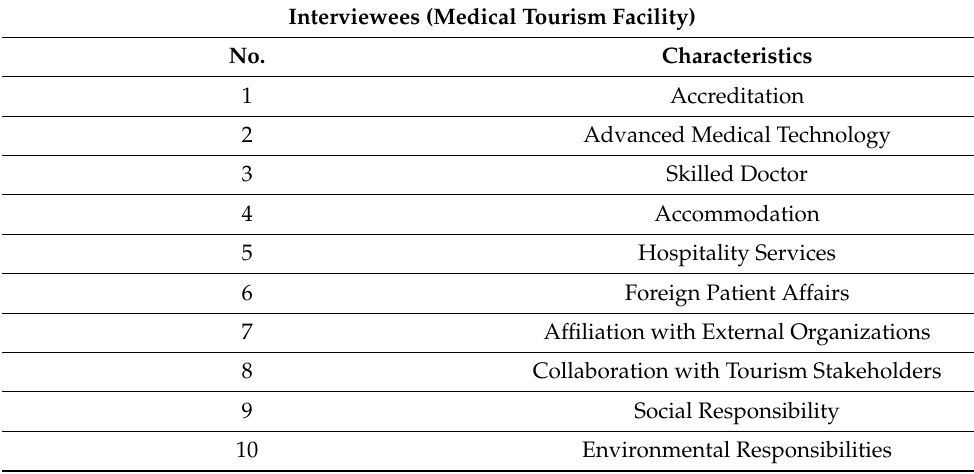
Table 4. The characteristics of medical tourism